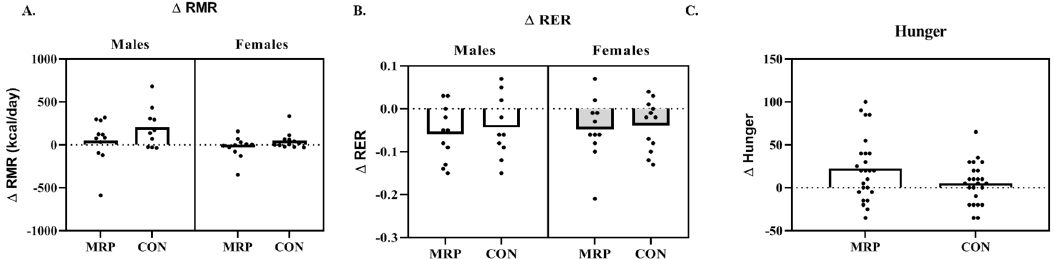
Figure 3. Individual responses for change in ( A ) resting metabolic rate ( ∆ RMR); ( B ) resting respiratory exchange ratio ( ∆ RER); and ( C ) hunger for the meal replacement (MRP) and control (CON) groups.